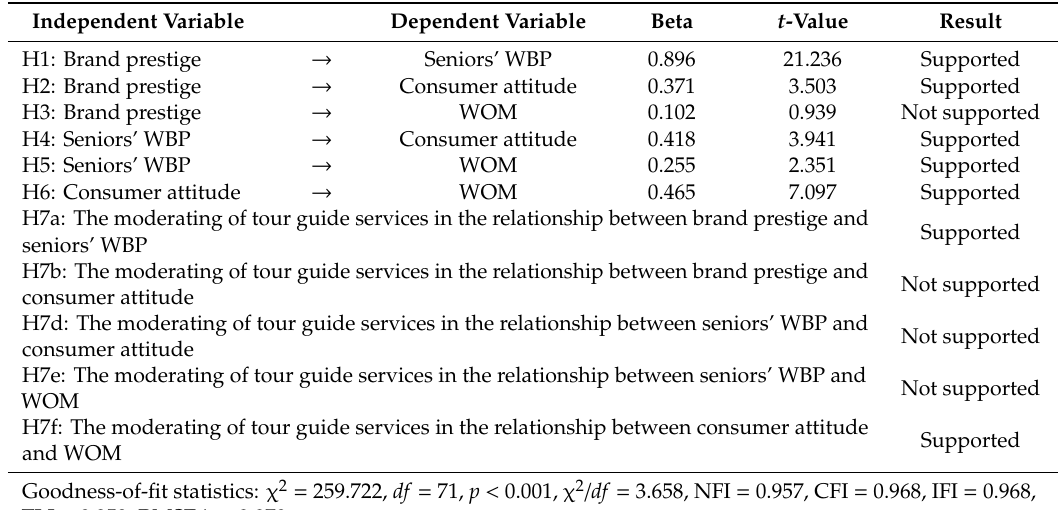
Table 4. Standardized parameter estimates for structural